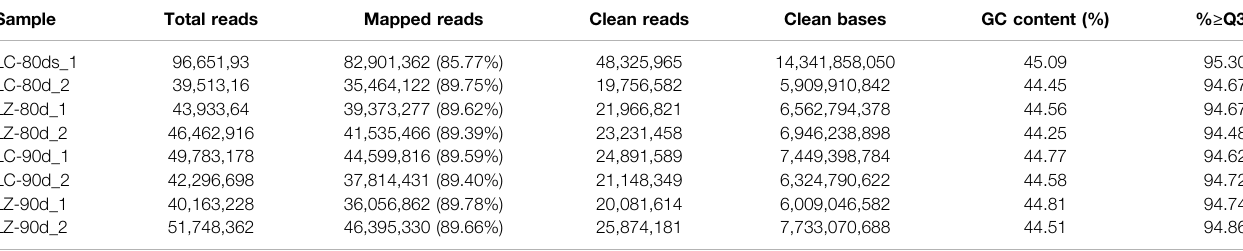
TABLE 2 | Characteristics of RNA-seq results of different samples. Sample